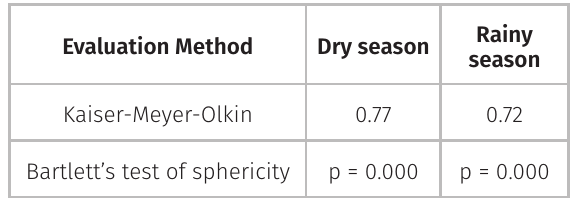
Table III. KMO criterion and Bartlett’s test of sphericity results for the dry and rainy seasons.